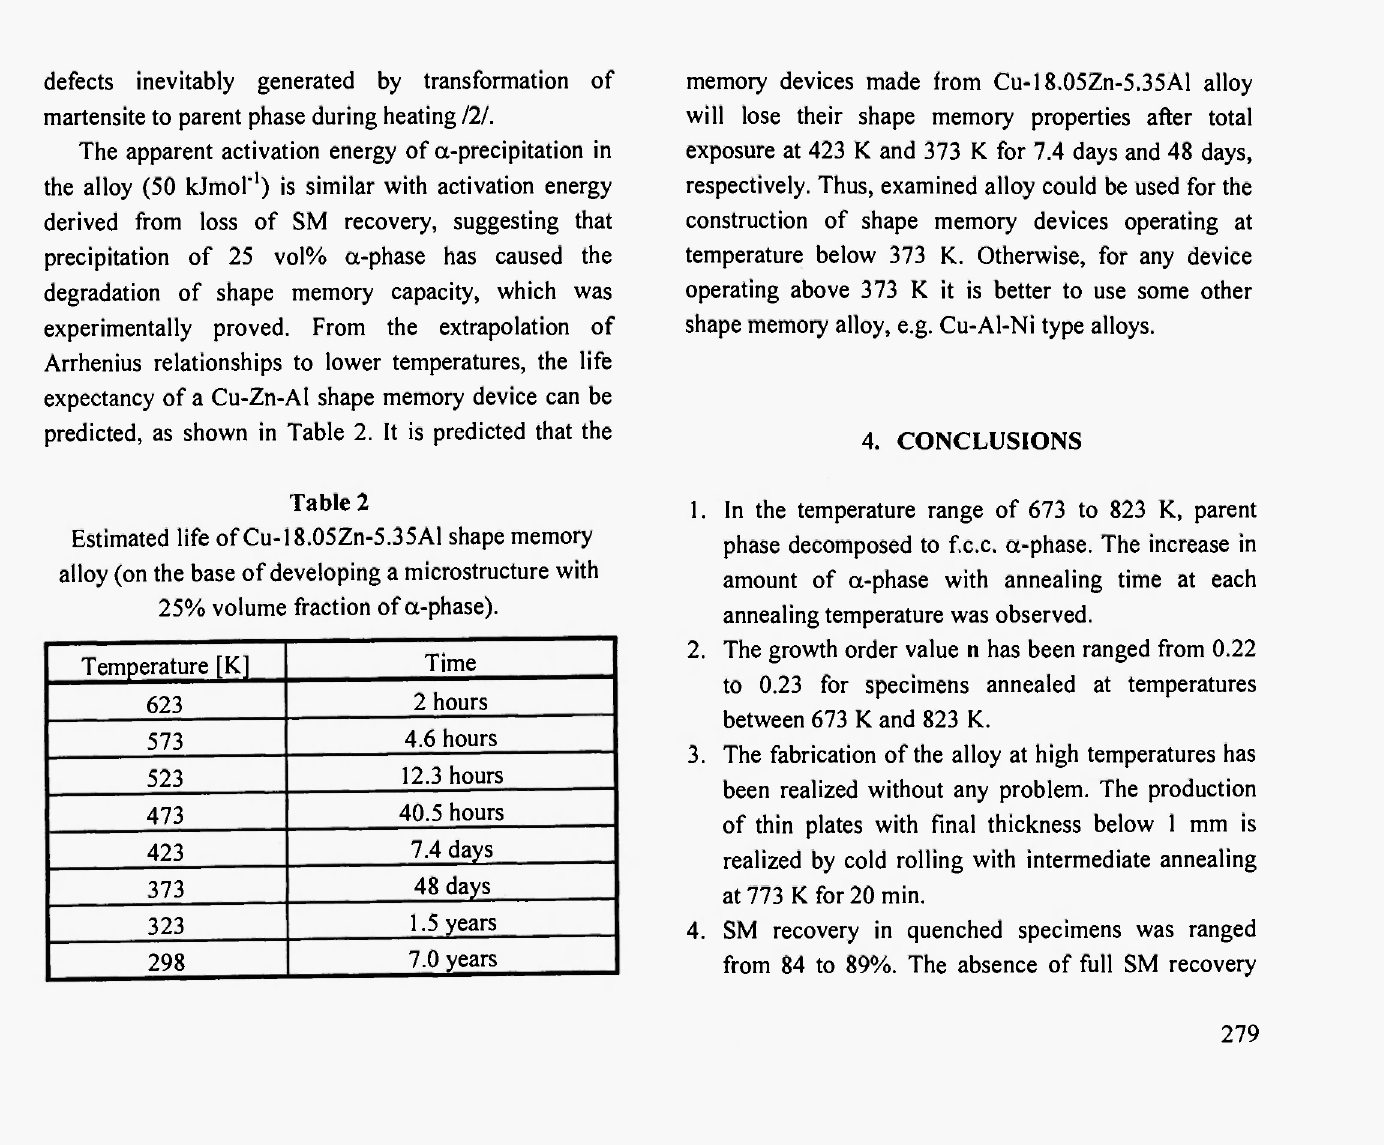
Fig. 12: Arrhenius plot of the length of aging periods vs temperature to reach 50 % decrease in SM recovery.